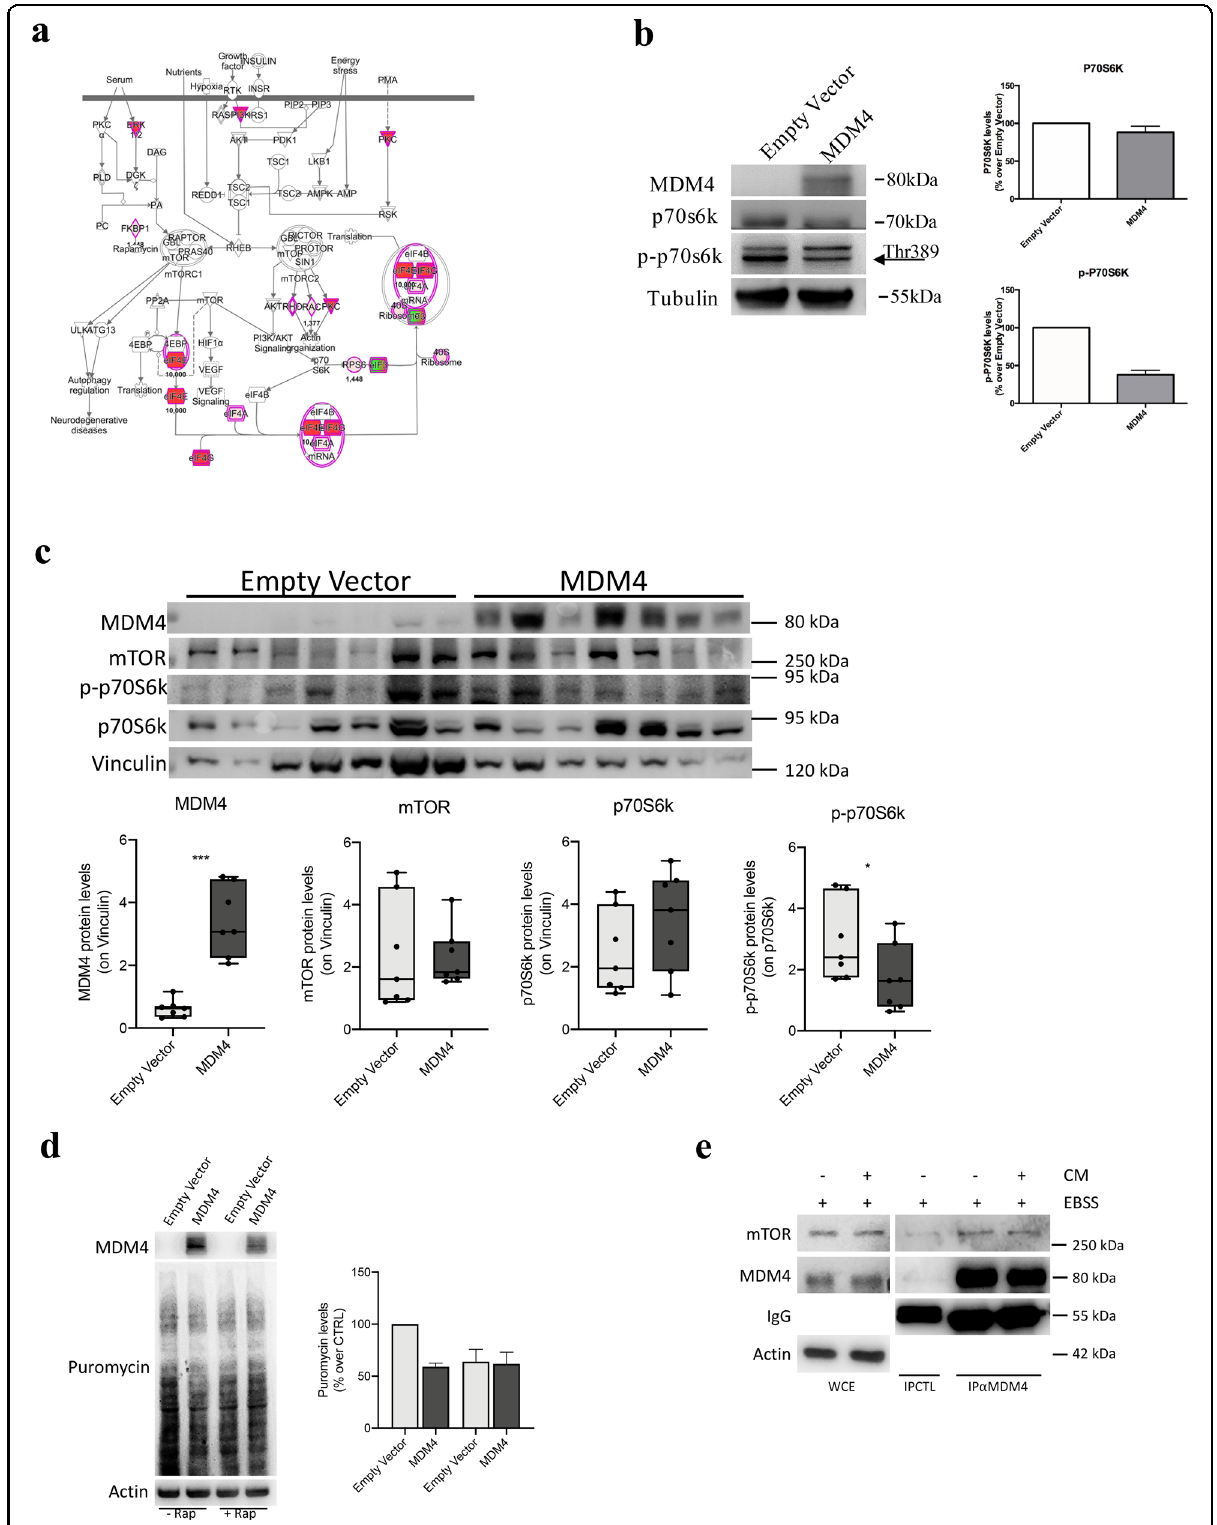
Fig. 5 (See legend on next